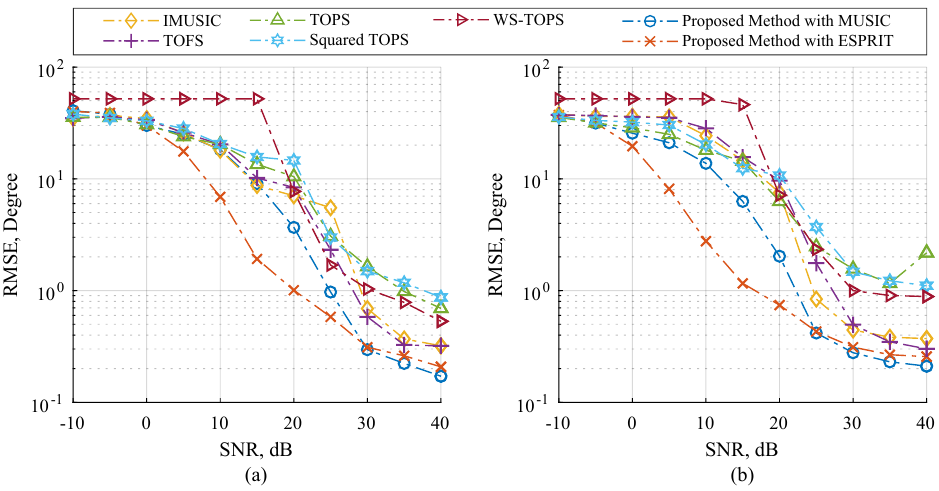
Figure 2. RMSE estimation performance versus SNR on Scenario 1; ( a ) three different human speeches, and ( b ) three uncorrelated musical sounds where six microphones are employed each subarray.